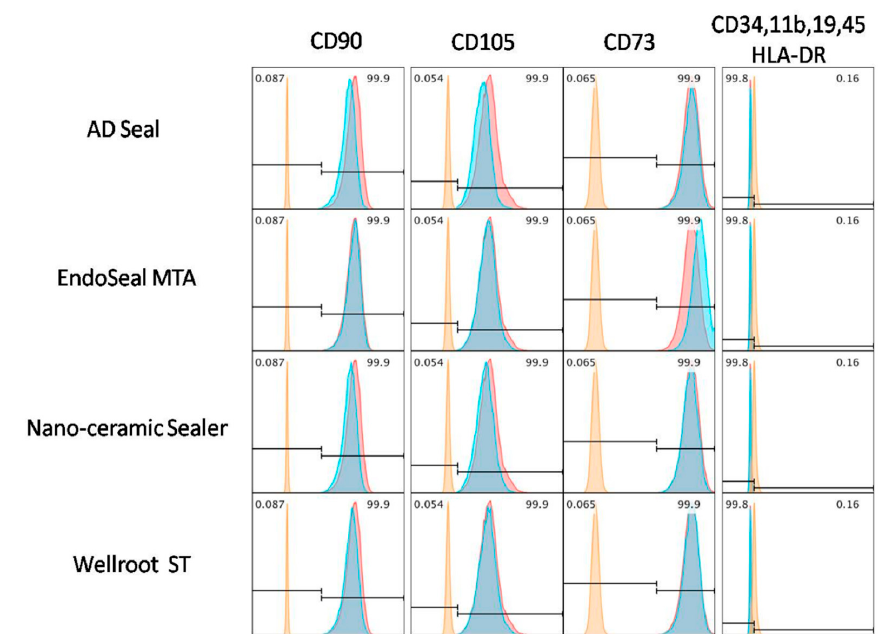
Figure 6. Mesenchymal phenotype analysis of hPDLSCs using flowcytometry. After culture in 1/4